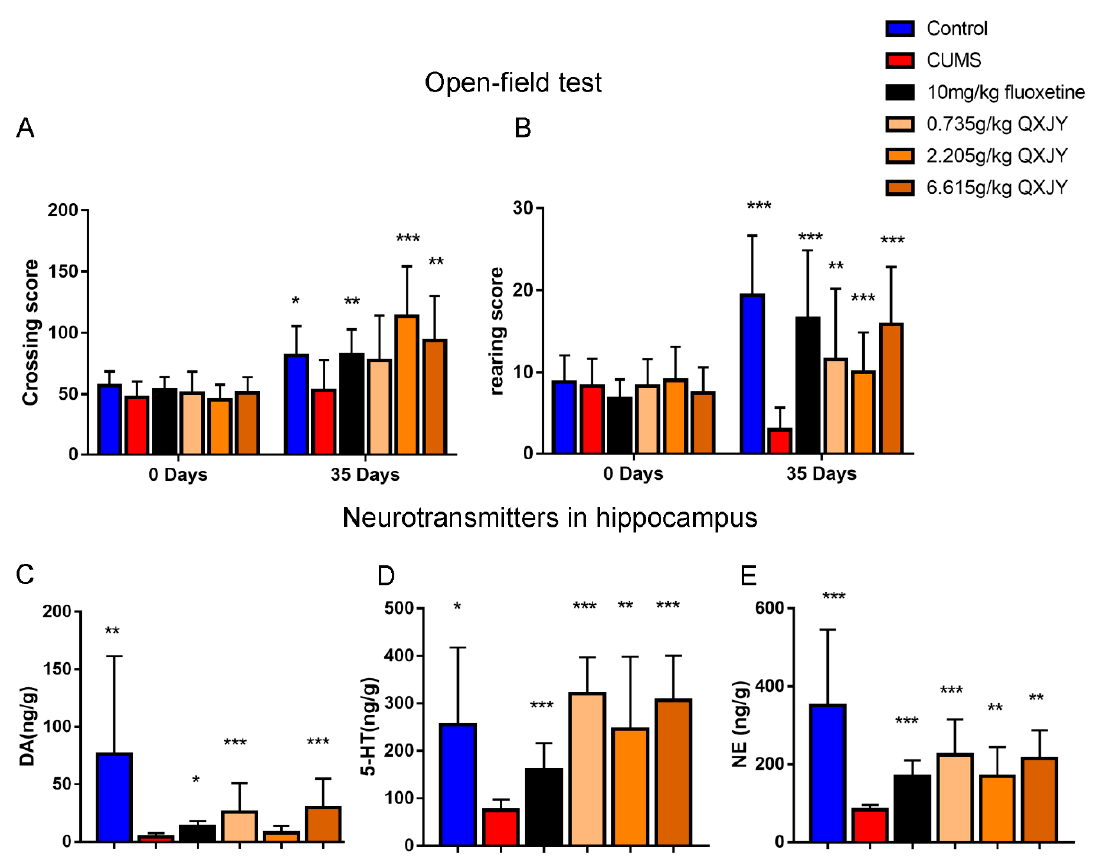
Figure 2. Effects of ZL on CUMS rats in OFT and neurotransmitters in hippocampus. Effects of ZL on OFT ( A , B ). Decrease of monoamine neurotransmitters in the hippocampus ( C – E ). All data are represented as mean ± SD. * p < 0.05, ** p < 0.01, and *** p < 0.001 versus CUMS group.